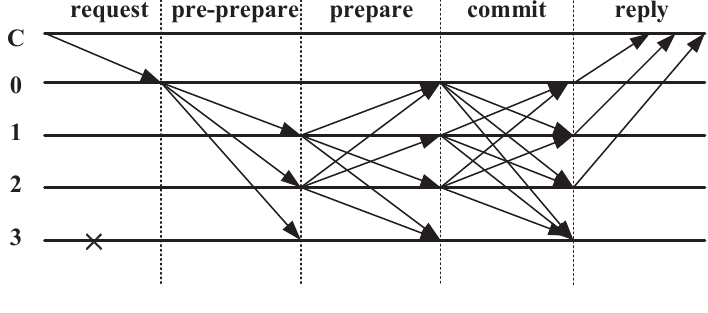
Figure 10. Byzantine